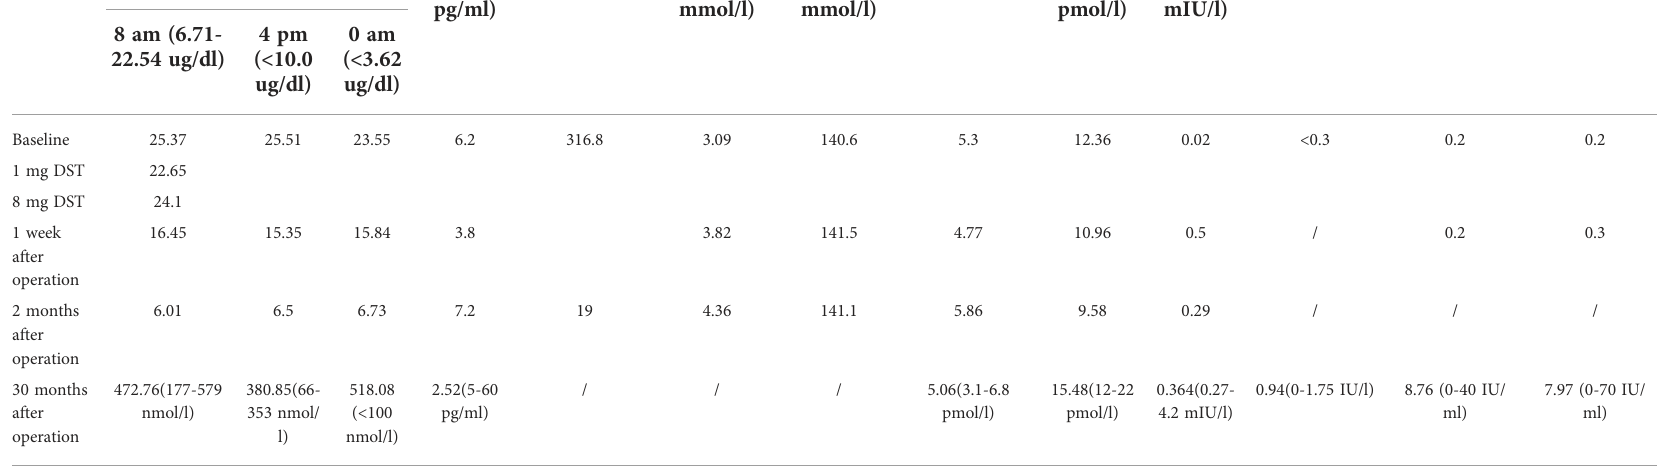
TABLE 1 Preoperative assessment and postoperative follow-up of the